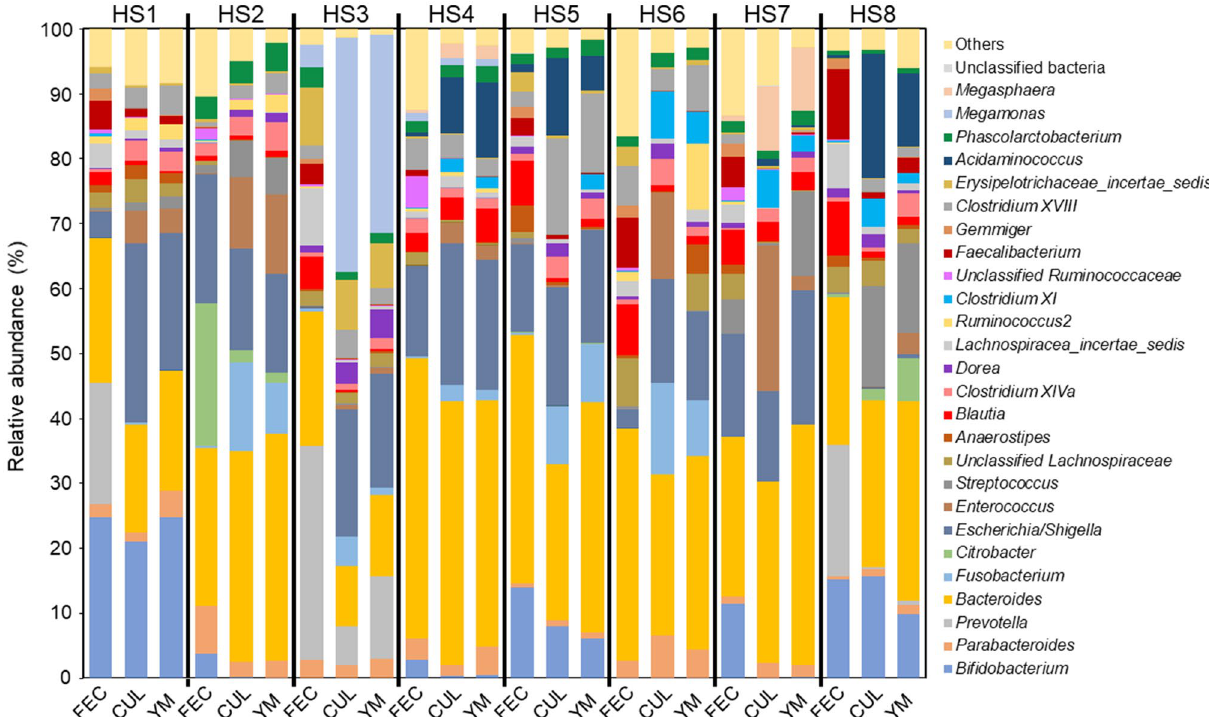
Figure 3. Genus-level compositional views of bacteria in eight human samples (HS1–HS8). Eight human faecal samples (FEC), the corresponding cultures without yeast mannan (CUL), and the corresponding cultures with the 0.4% yeast mannan preparation (YM) were sampled 30 h after the initiation of fermentation. Genera with low abundance (< 1.0%) and low similarity (< 97%) were included in ‘Others’ and ‘Unclassified bacteria’,